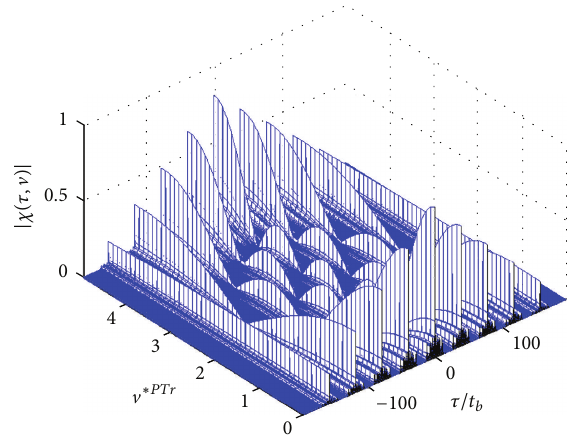
Figure 4: Ambiguity function of INS MCPC based on P4 code.